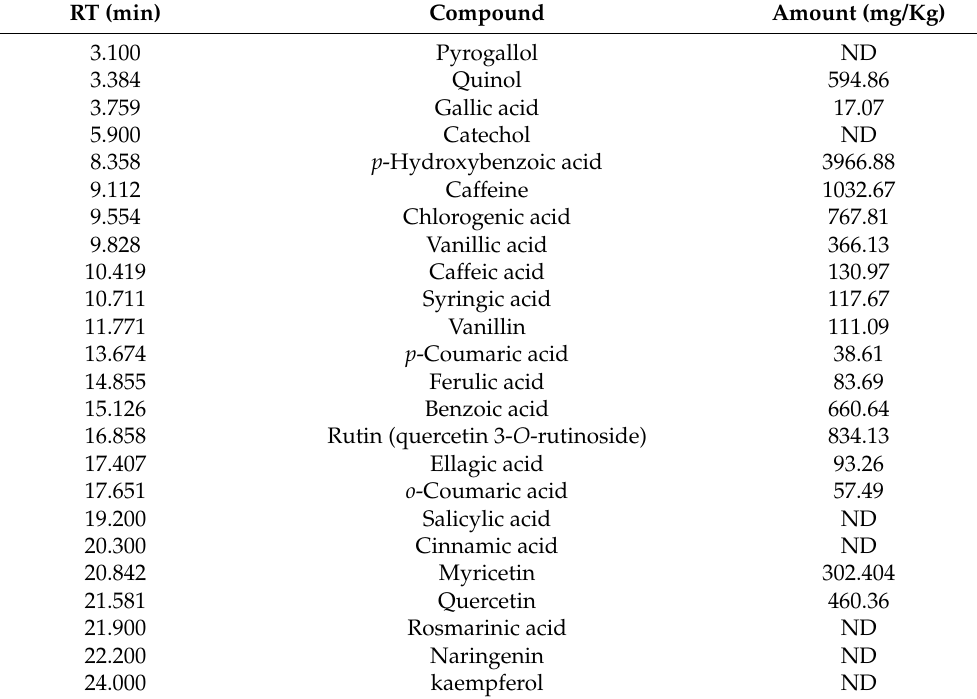
Table 8. Chemical compounds in Melia azedarach heartwood extract.